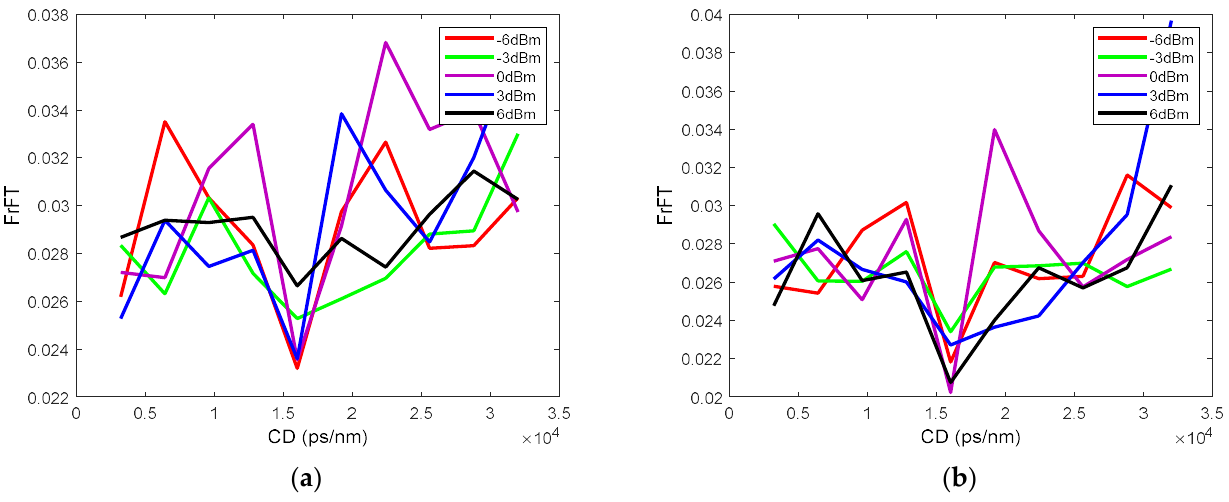
Figure 12. Relationship between ( a ) error rate and ( b ) estimation error with input power.